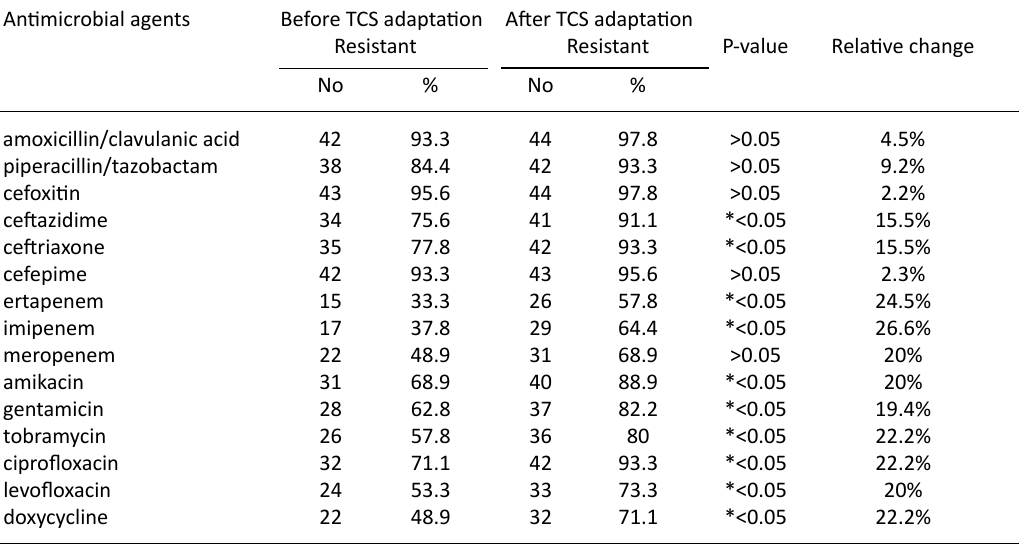
Table 4. Antimicrobial susceptibility among 45 E. coli isolates, before and after TCS adaptation Antimicrobial agents Before TCS adaptation After TCS adaptation Resistant Resistant